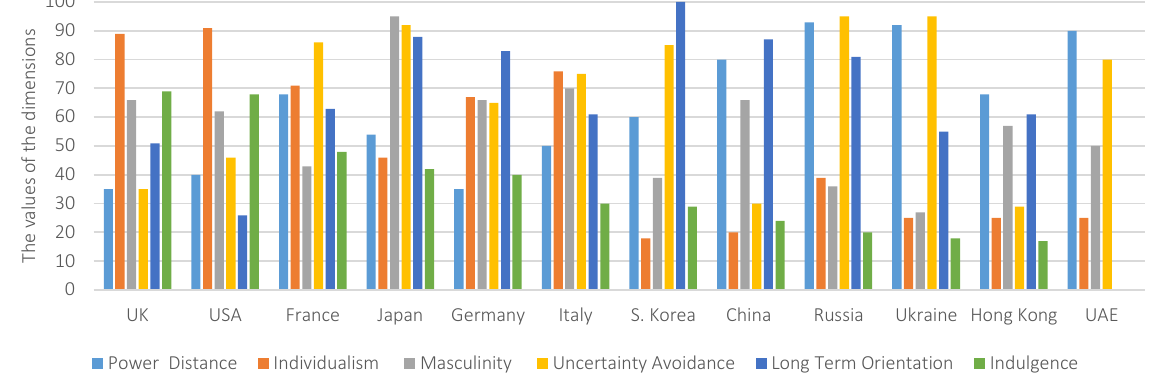
Figure 1. The values of the Hofstede’s cultural